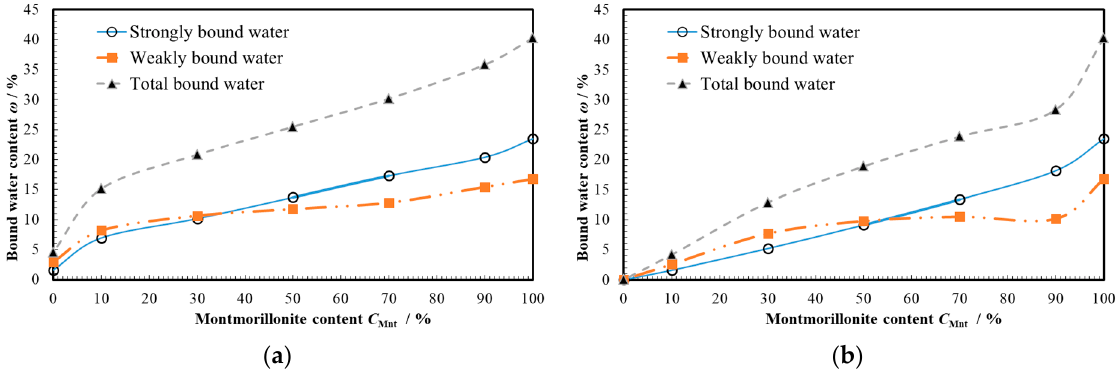
Figure 5. Relationship between bound water and Mnt. content. ( a ) Type II (mixed soils with Mnt + Kln). ( b ) Type III (mixed soils with Mnt + Fsp).